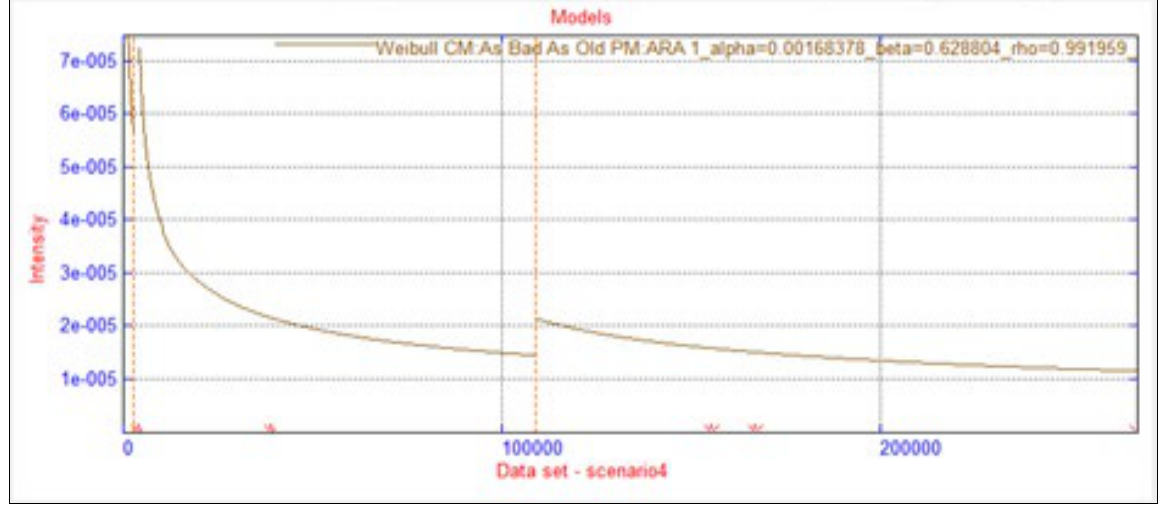
Figure 3. Failure intensity of scenario 4 for model CM ABAO – PM ARA 1